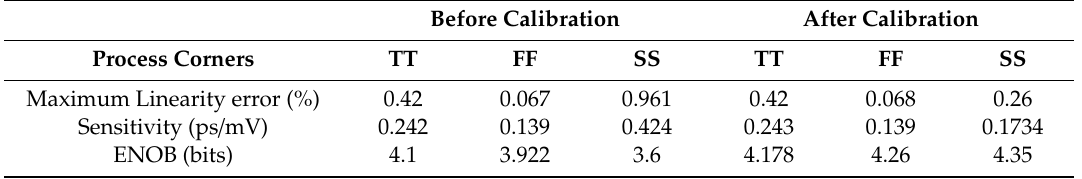
Table 4. Performance of the second proposed VTC at process corners before and after calibration.